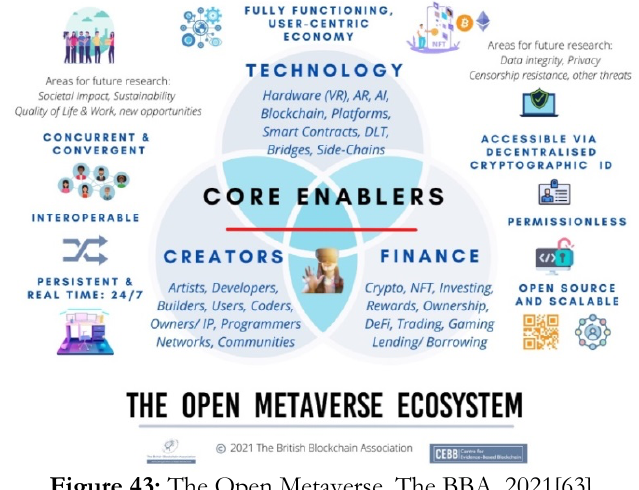
Figure 43: The Open Metaverse, The BBA, 2021[63]